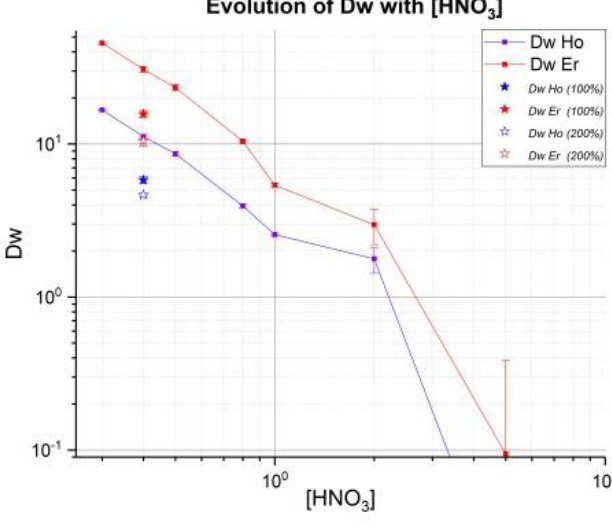
Figure 6. D w de Er/Ho with LN2.